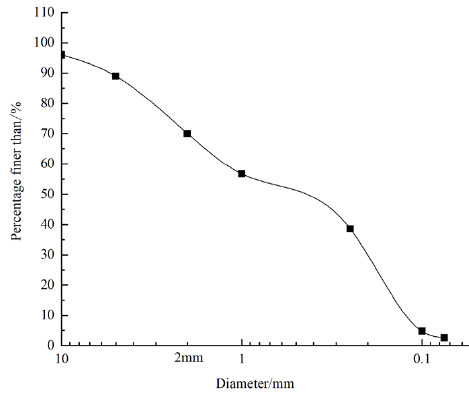
Figure 4. Physical property curve of Xining loess. ( a ) Grain size distribution of Xining loess; ( b ) compaction curve of Xining loess.